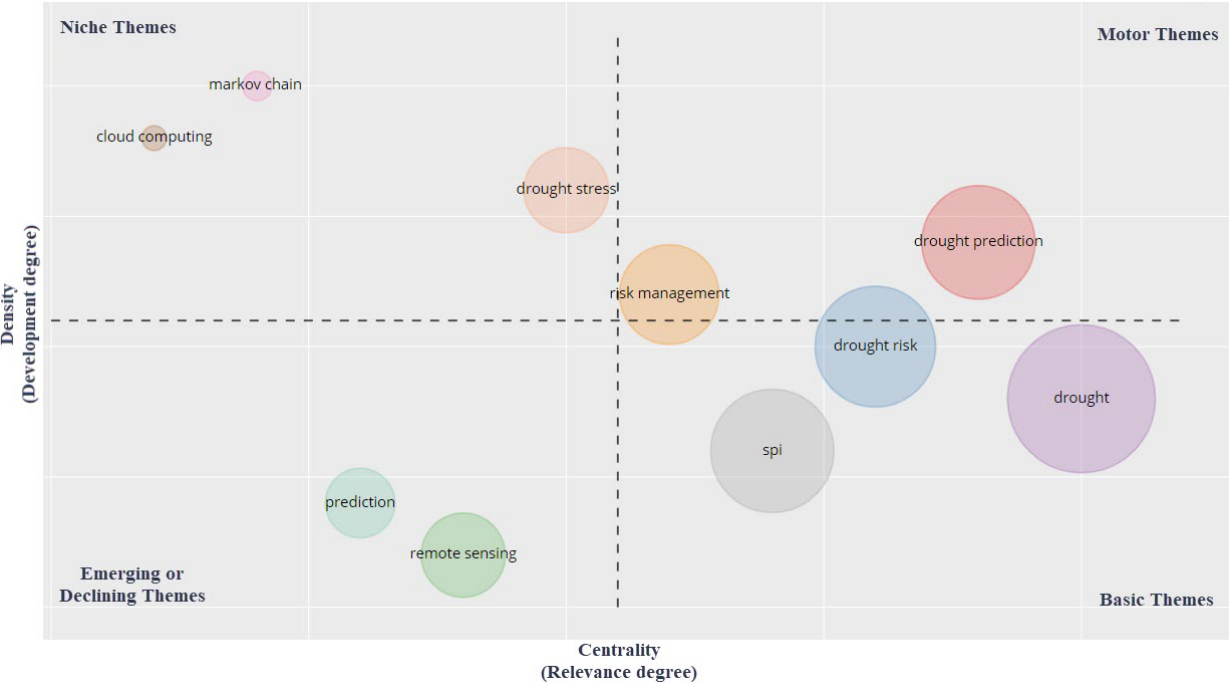
Figure 16. Thematic map.